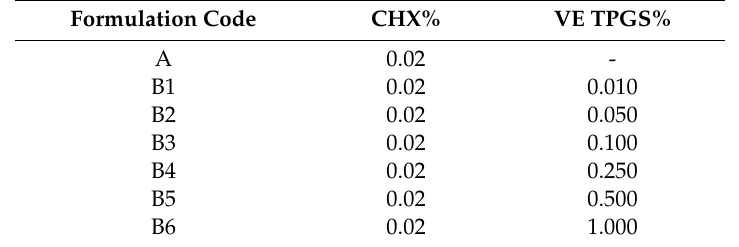
Table 1. List of donor corneas incubated with di ff erent combinations of CHX and